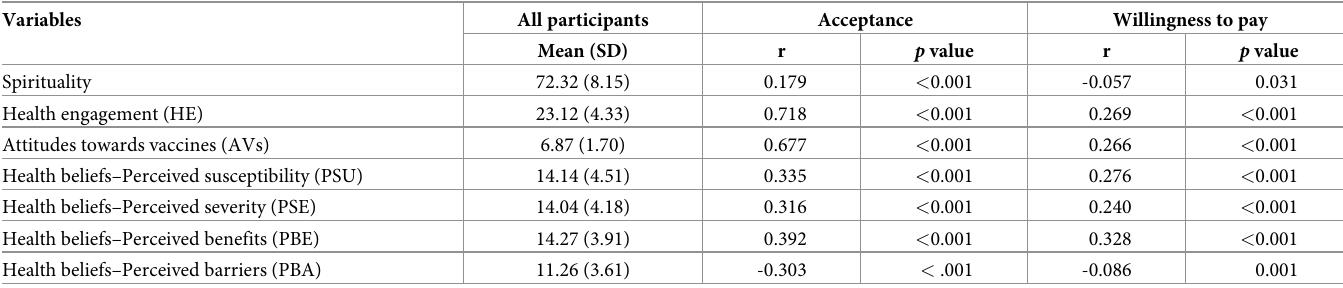
scores, but were not correlated with a willingness to pay, except for PBA3 are outlined in S2 Table. S3 Table presented the findings of the multiple linear regression performed of all the indica- tors of spirituality, HE, health beliefs, and AVs for vaccine acceptance and willingness to pay. Further statistical test showed that getting high spirituality was connected with a higher vac-